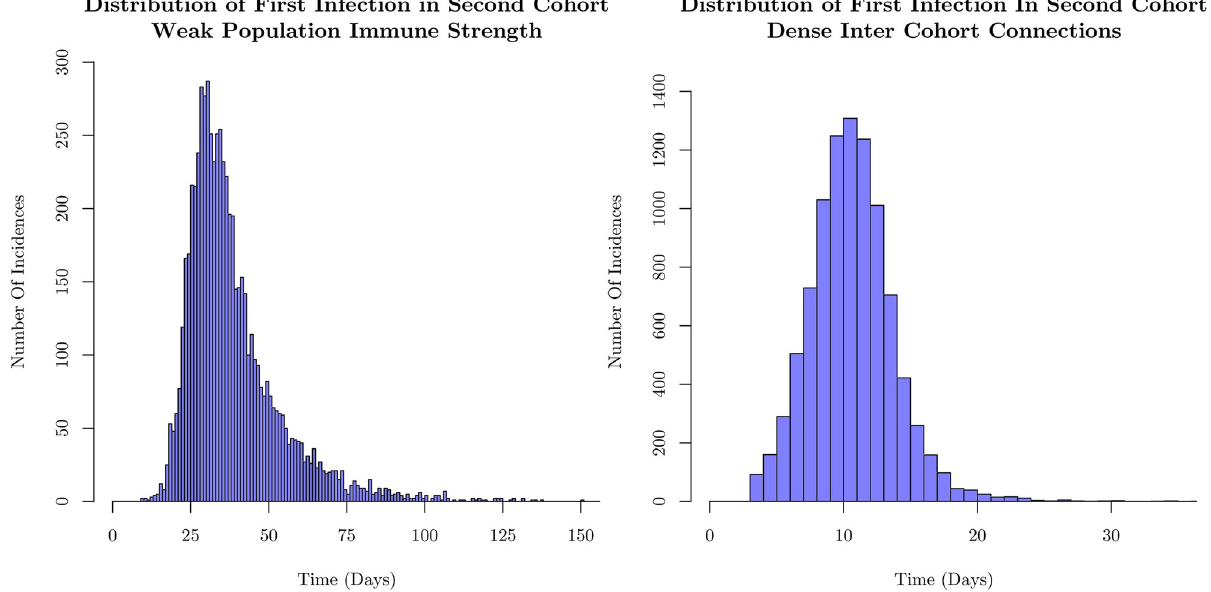
Fig 6. Distributions displaying the occurrence time of the first infection in the second cohort for weak immune strength. The figure on the left is for cohorts in which 2% of the agents are connected to the second cohort on the left, and on the right is for cohorts in which 10% of the agents are connected to the second cohort. The intra-cohort structure remains unchanged, and the immune strengths of the two cases are the same. The sparsely connected structure displays a very wide distribution of first infection times, despite rapid intra-cohort spread as shown in Fig 5. We show that with more inter-cohort connections, the distribution is both shifted earlier in time, as well as substantially narrowed. This demonstrates that much of the stochasticity in the model is driven by the weak inter-cohort connections that are relatively few in number slowing the spread through the population as discussed in the text. The histograms each represent 10,000 sample